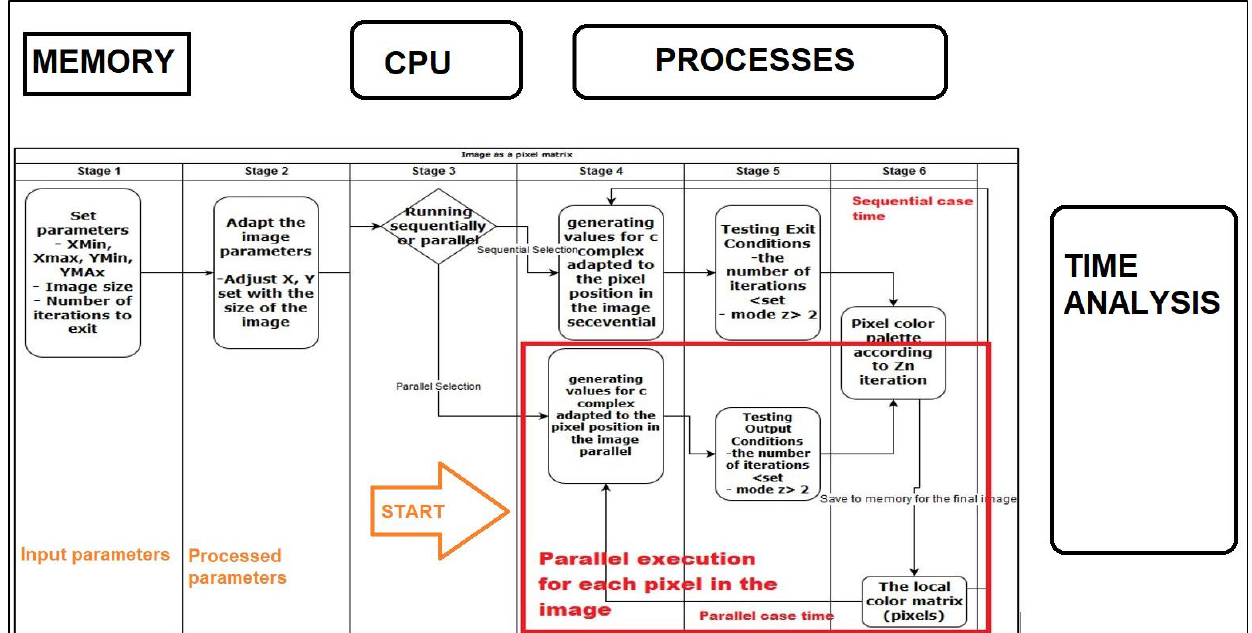
Figure 1. Description of the functional architecture of the application. Highlighting for the Mandelbrot parallel generation variant.